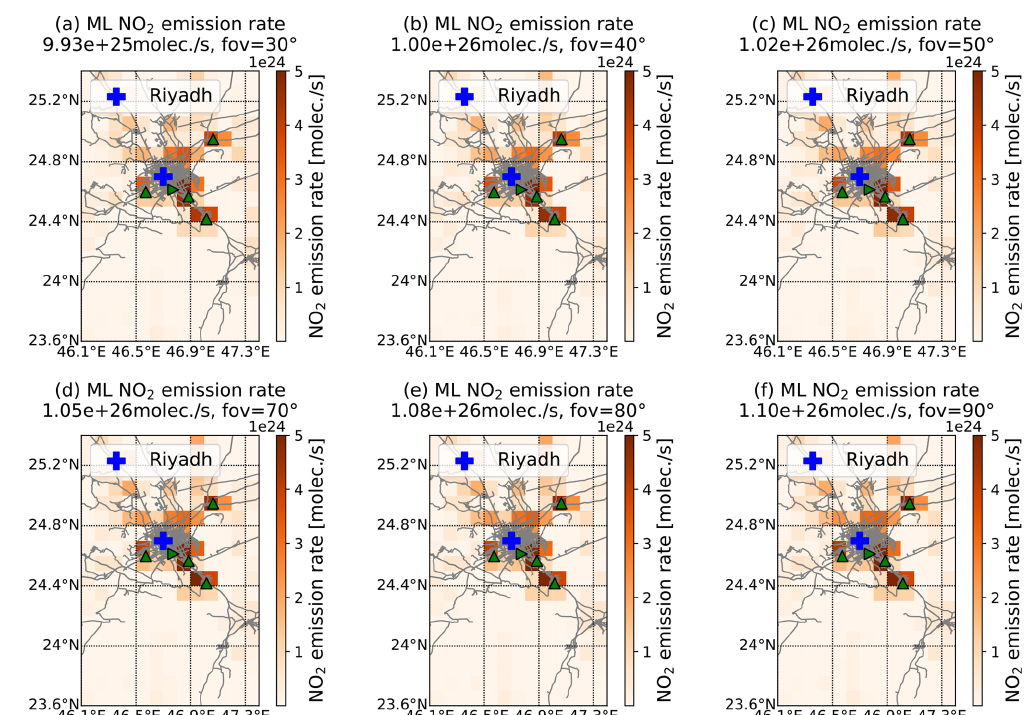
Figure A15. Estimated emission rates in Riyadh for different angles ( α ) of the emission cone from 30 to 90 ◦